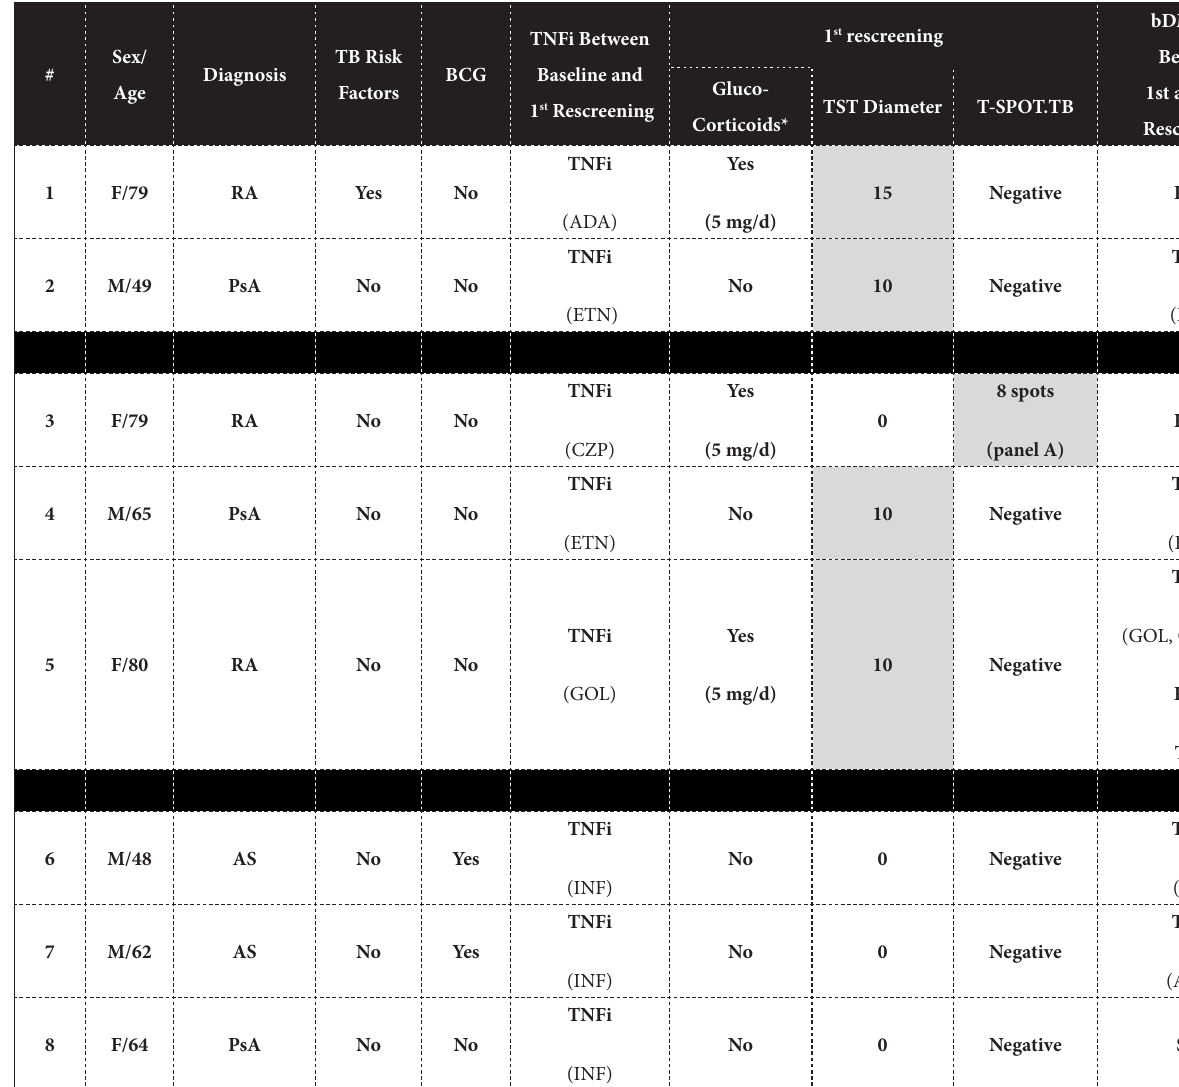
Table 2. Characteristics of patients that converted at least 1 TB screening test